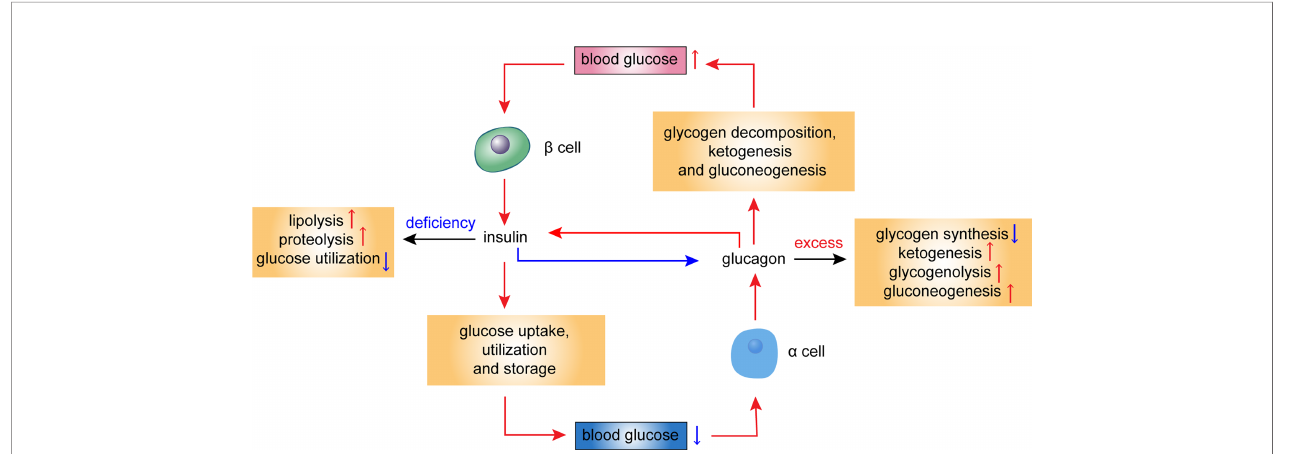
FIGURE 1 | Hormonal regulation of glucose homeostasis in the islet cells. This diagram illustrates the metabolic effects of glucagon and insulin. Blood glucose levels in fl uence secretion of insulin and glucagon. Insulin de fi ciency leads to elevated lipolysis, increased proteolysis, and decreased glucose utilization, while excess glucagon leads to decreased glycogen synthesis, increased ketogenesis, elevated glycogenolysis, and gluconeogenesis. Red arrows refer to a stimulatory effect, while blue arrows refer to an inhibitory